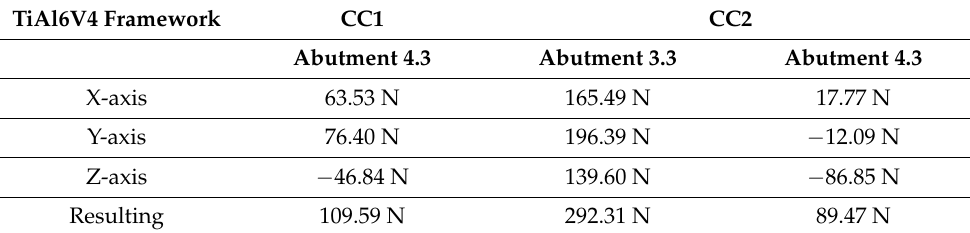
Table 2. Results of FEA evaluation for the TiAl6V4 framework in CC1 and CC2 R = resulting (reaction) force; X,Y,Z = (reaction) components of the resulting force; unit of measurement = reaction force (N). TiAl6V4 Framework CC1 CC2 Abutment 4.3 Abutment 3.3 Abutment 4.3 X-axis 63.53 N 165.49 N 17.77 N Y-axis 76.40 N 196.39 N − 12.09 N Z-axis − 46.84 N 139.60 N − 86.85 N Resulting 109.59 N 292.31 N 89.47 N